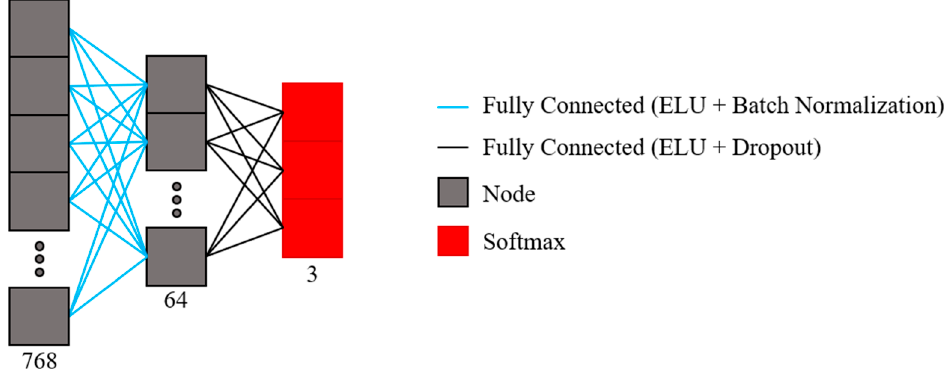
Figure 5. Base network architecture .